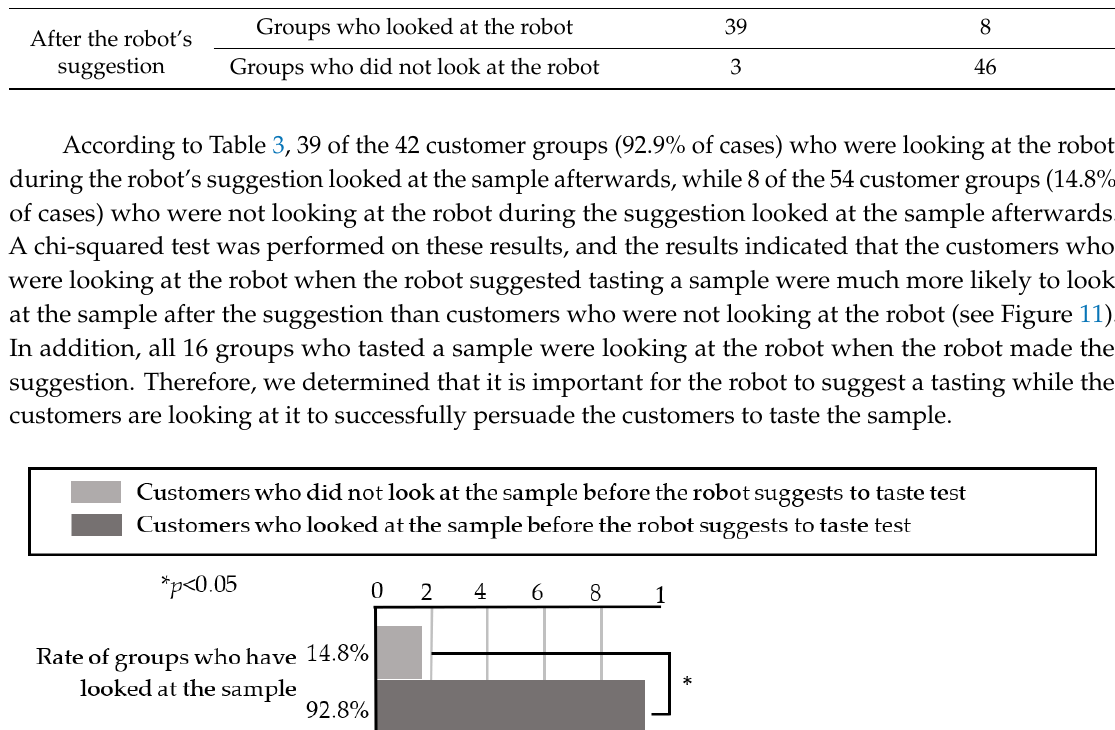
Table 8. Responses when the robot offered a sample.